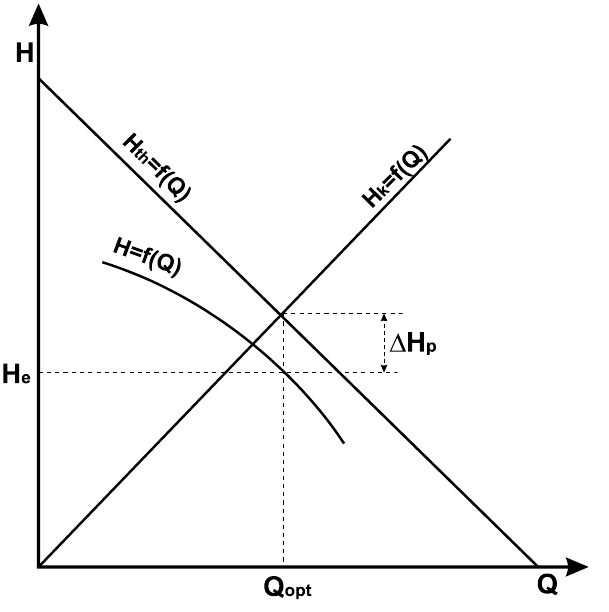
Figure 2. Characteristics of the cooperation between the impeller and the stator: H th = f(Q)—characteristics of the impeller, H k = f(Q)—characteristics of the stator, H = f(Q)—actual characteristics of the pump (the author’s elaboration).